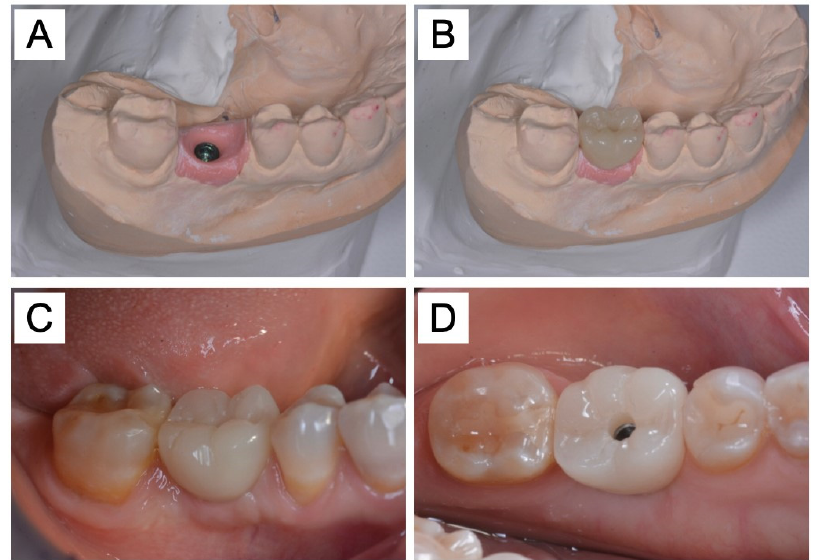
Figure 16. A screw-retained temporary prosthesis. ( A ) Peri-implant tissue shaping on the master cast. ( B ) Temporary acrylic resin single crown, screwed onto the master cast. ( C ) Intraoral placement of the temporary prosthesis (buccal view). ( D ) Intraoral placement of the temporary prosthesis (occlusal view).